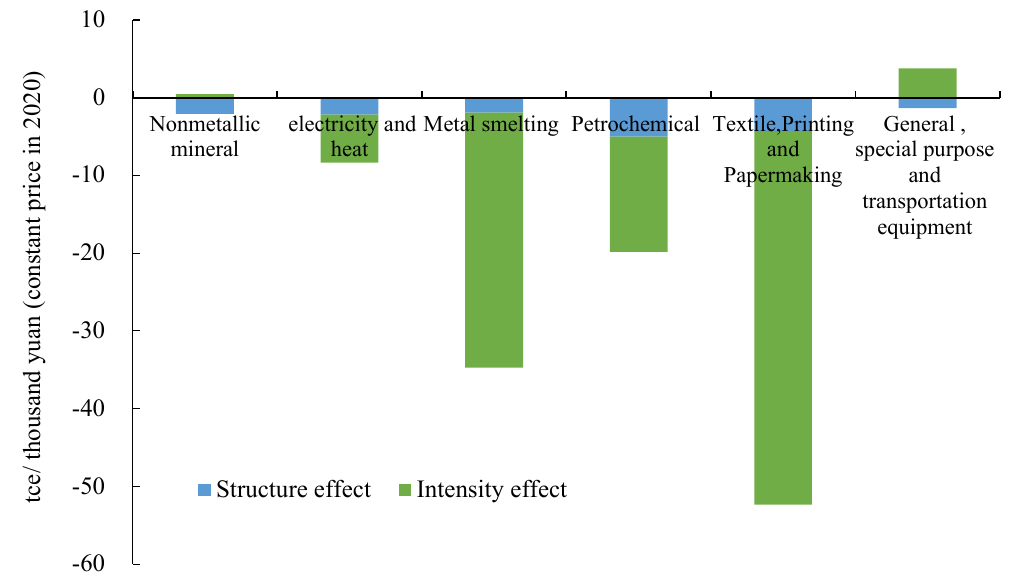
Figure 5. Decomposition results of energy consumption per unit of added value in major industrial sectors in Zhejiang (2015–2020). Data source: authors’ calculations.